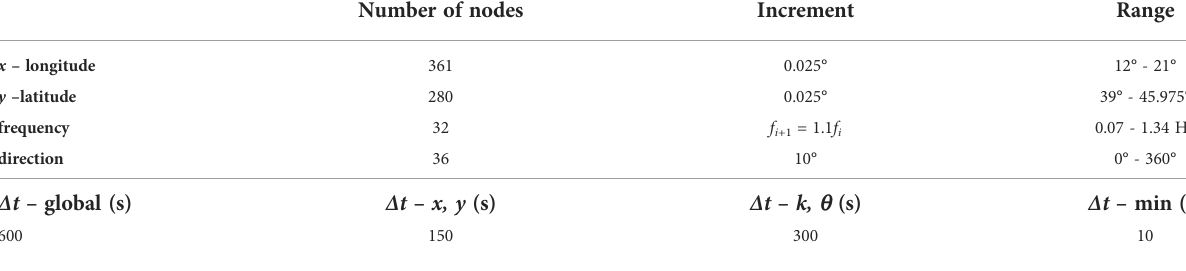
TABLE 1 Model setup: Computational domain characteristics (physical and spectral space) and timesteps Δ t